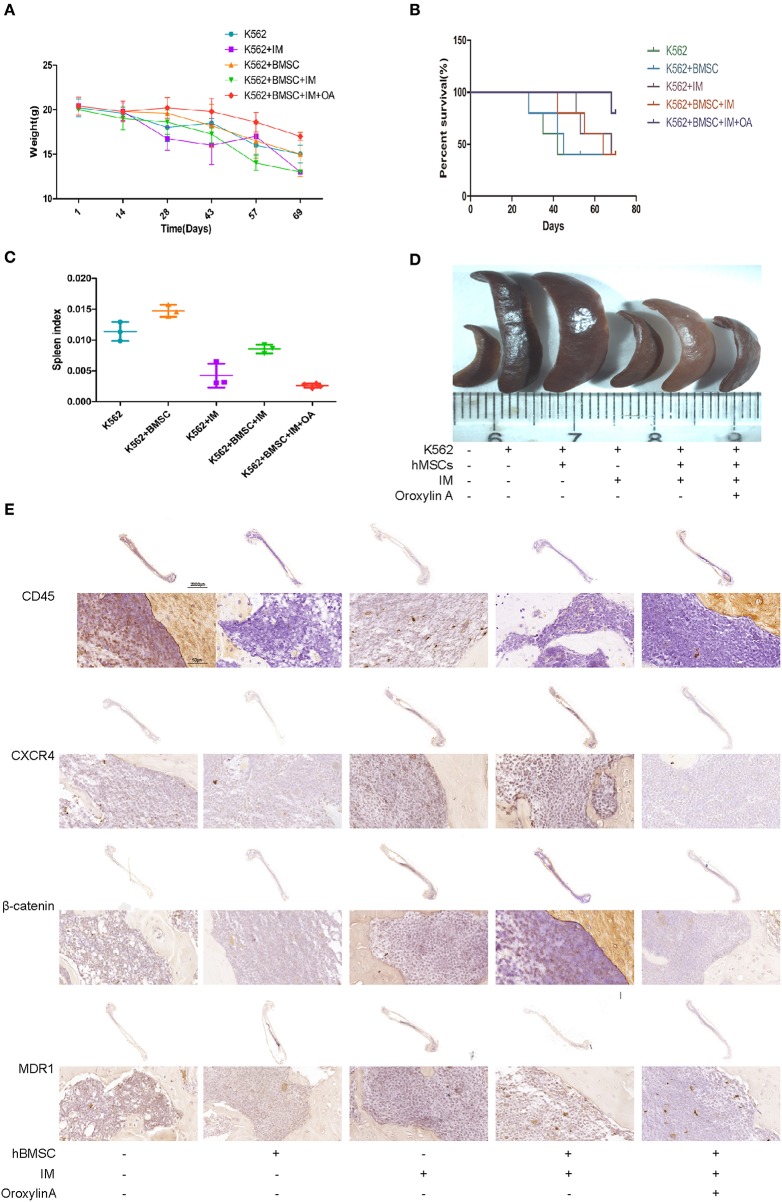
The reversal effect and mechanisms of Oroxylin A in vivo. Tumor xenografts inoculated with K562 cells or combinations with hBMSCs were treated with IM (200 mg/kg) or combination with Oroxylin A (80 mg/ kg) every other day orally for 4 weeks. (A) The analysis of body weight after indicated. (B) Survival Curves of mice after different treatment. (C) The weight of spleens of treatment groups. (D) Images of representative spleens. (E) Representative IHC staining of murine BM, for human CD45, β-catenin and P-gp antigen.